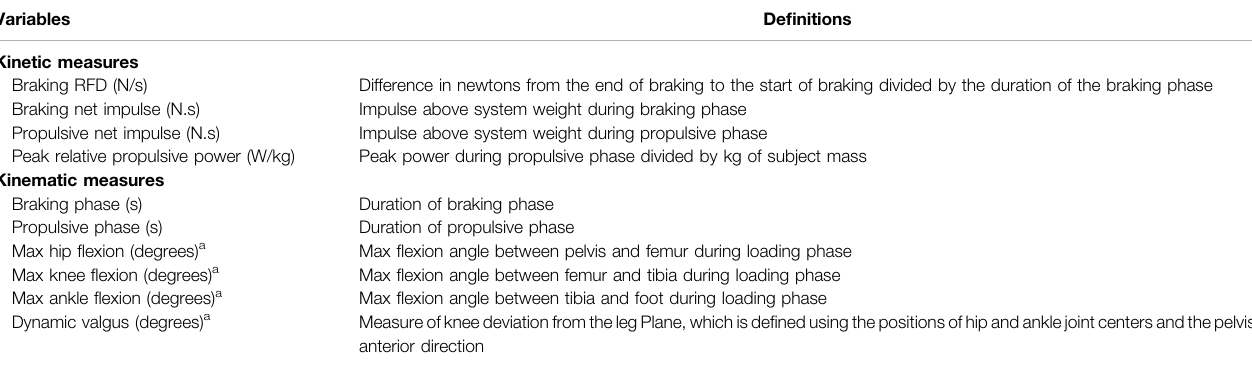
TABLE 1 | K-means clustering variables de fi nitions. Variables De fi nitions